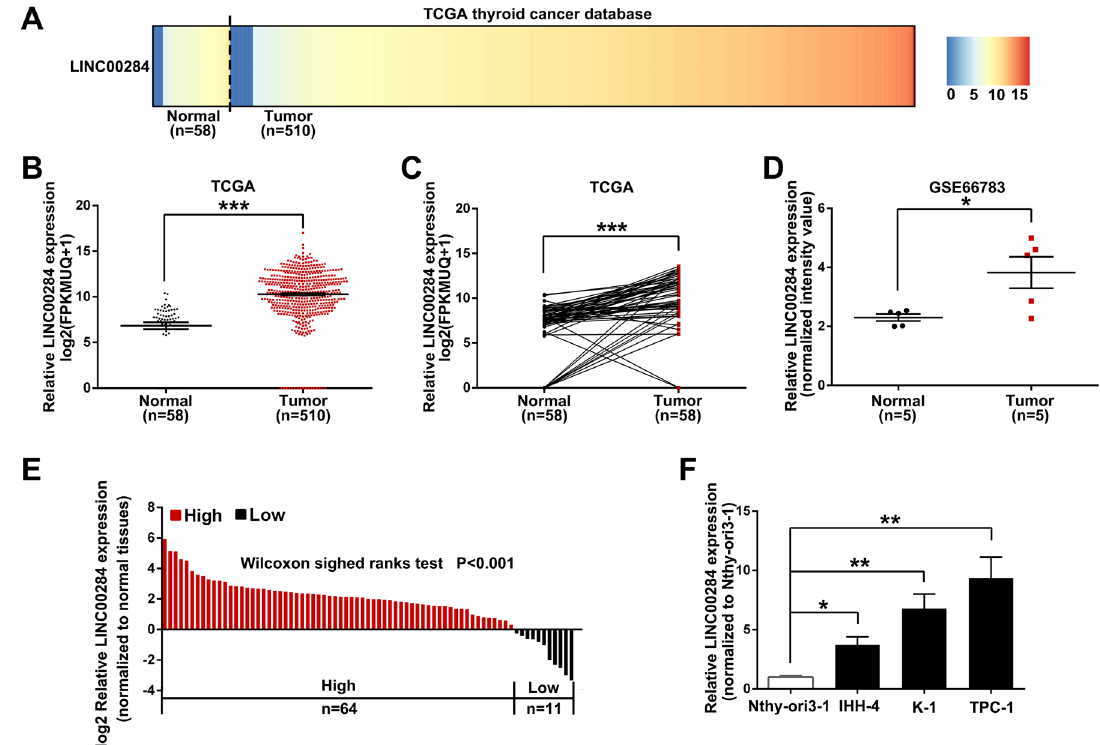
Fig. 1 LINC00284 is highly expressed in papillary thyroid cancer (PTC). A Heat map analysis of LINC00284 expression in TC tissues and normal tissues from TCGA. B T -test was conducted to assess the differential expression of LINC00284 in TC samples and normal samples using TCGA data. C Relative LINC00284 expression in paired TC samples and normal samples in TCGA. D The data of GEO was extracted to evaluate LINC00284 expression in paired TC specimens and normal specimens. E qRT-PCR analyses of LINC00284 expression in PTC tissues and adjacent noncancerous tissues from our own hospital. F qRT-PCR was conducted to analyze LINC00284 expression in the normal thyroid follicular epithelial cell (Nthy-ori3-1) and PTC cells. Values indicated mean ± standard errors. * P < 0.05, ** P < 0.01, and *** P <